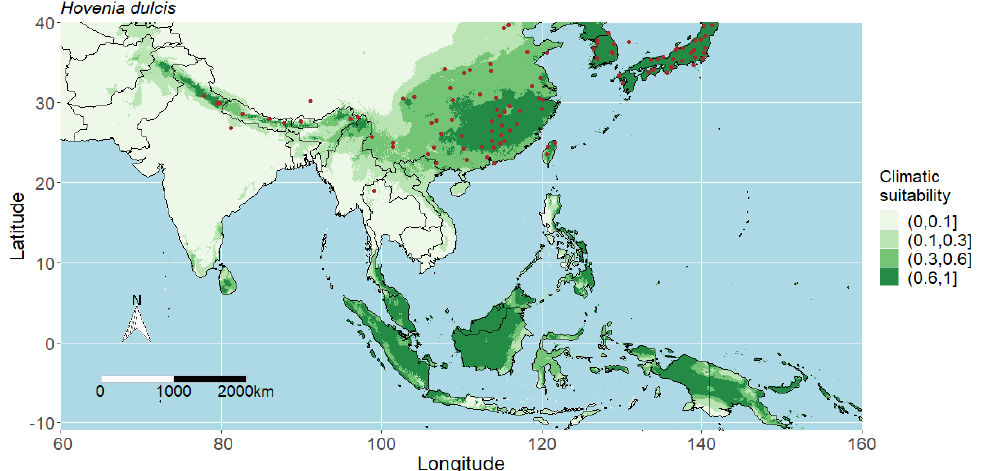
Figure 5. Hovenia dulcis : confirmed records (brown circles) and potential current climate suitability,